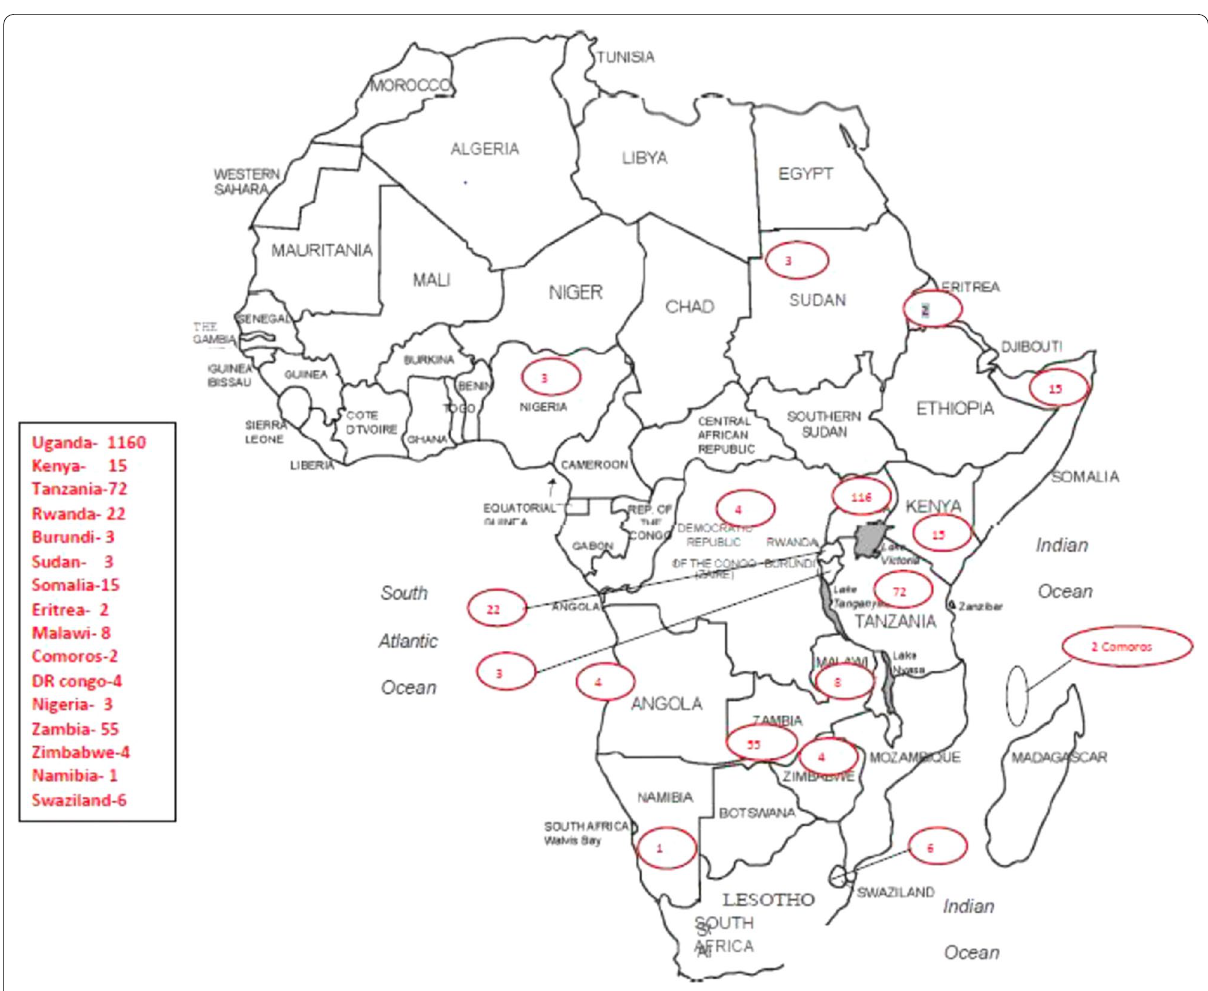
Fig. 1 Countries in Africa where ECUREI trainees have come from and the number of trainees per country for the period